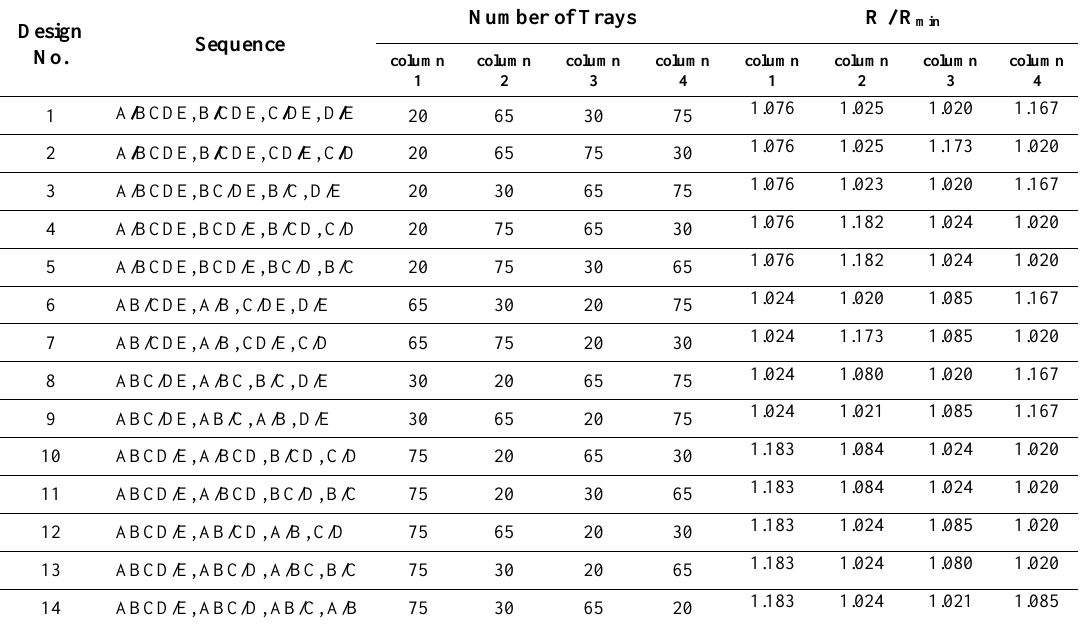
Table 12. Optimizing of reflux rations in all of the designed column sequences.